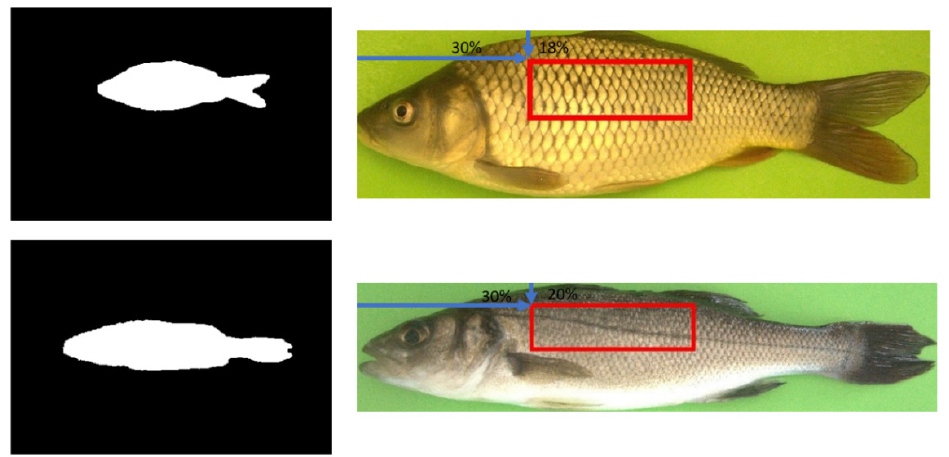
Figure 4. Identification scheme. ( Left images ), fish detected in the original image (black and white mask) what is the output of the of fish detection procedure; ( Right images ), ROI (ROI(LL) for seabass (bottom image) and ROI1 for carp (upper image) localized in the fish bounding box by the defined percentage of fish width and height.